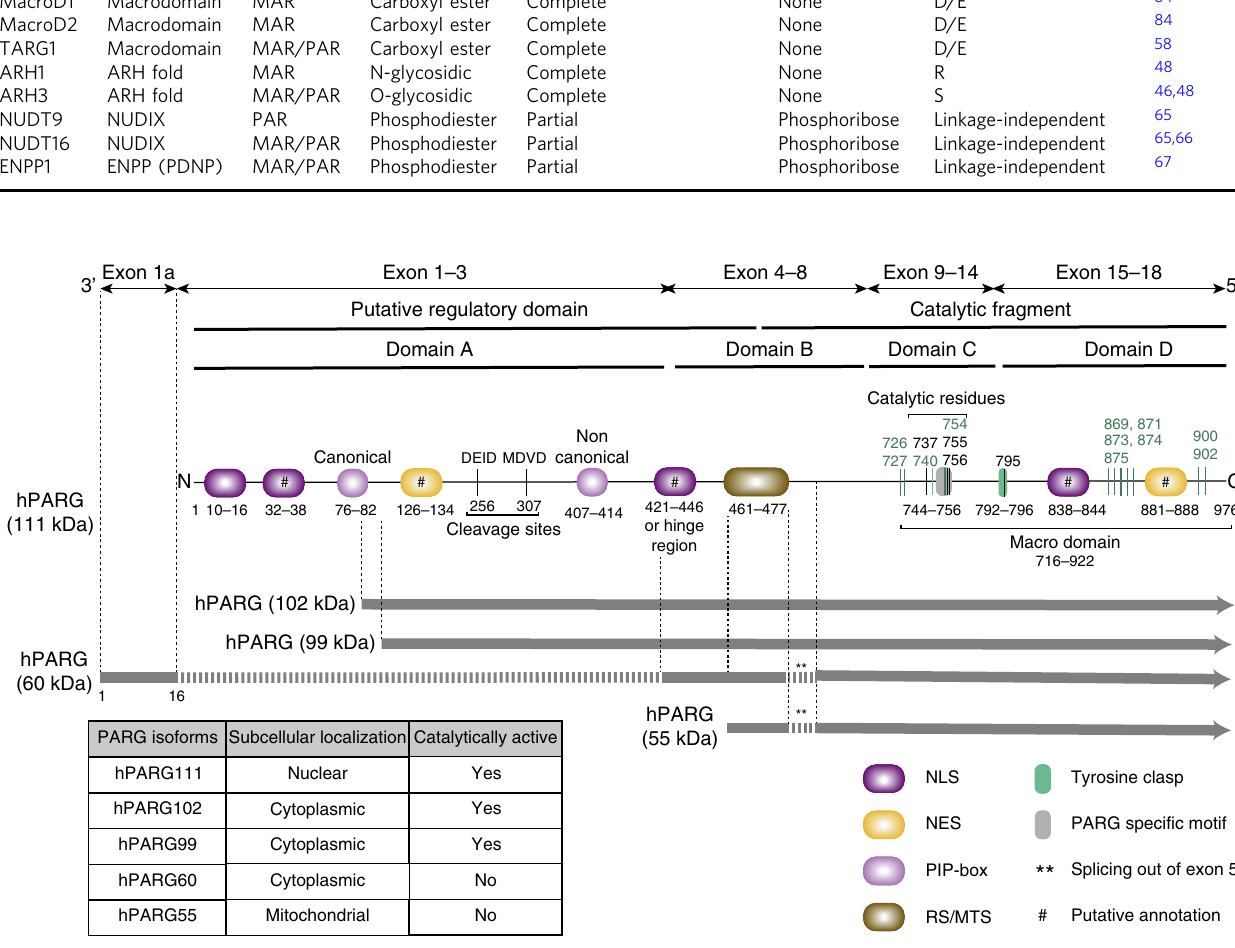
Fig. 2 Schematic representation of human PARG and its isoforms. Human PARG originates from a 3198 bp mRNA sequence with a single 2931 bp open reading frame (ORF). The ORF contains 18 exons and encodes a protein of 976 amino acids with a molecular weight of 111.1 kDa. This mRNA undergoes alternative splicing to produce different PARG isoforms. Five human PARG transcripts have been identi fi ed. Full-length human PARG (hPARG111) contains an N-terminal regulatory domain and a C-terminal catalytic domain that is essentially a macrodomain fold. hPARG102 and hPARG99 are translated from the start codons located in exon 2 and exon 3, respectively. hPARG60 results from alternative splicing that connects exon 1a, exon 4, and exons 6 – 18. Because of the usage of a facultative exon (exon 1a), hPARG60 has an alternative N-terminal protein sequence of 16 amino acids that is unique to this isoform. hPARG55 is produced from the initiation of translation at the start codon located in exon 4. Exon 5 is spliced out in both hPARG60 and hPARG55 isoforms. PARG can be sub-classi fi ed into four different domains. Domain A, which includes exons 1 – 3, forms the majority of the putative regulatory domain. This region contains two caspase-3 cleavage sites at amino acid position 256 (DEID) and 307 (MDVD). An uncharacterized nuclear localization signal (NLS) overlaps with a hinge region between the putative regulatory domain and the catalytic fragment. Furthermore, PARG comprises domain B (exons 4 – 8), domain C (exons 9 – 15) and domain D (exons 15 – 18). The latter two domains form the base of the macrodomain fold and contain the catalytic pocket and ligand binding sites. The catalytic residues (Asp737, Glu755, and Glu756) and Tyr795, which interacts with PARG inhibitor ADP-HPD are indicated as black lines. Residues colored in green have been implicated in the binding of ADP-ribose. Furthermore, colored boxes denote PARG-speci fi c motif (GGG-X 6 – 8 -QEE), regulatory segment/mitochondrial targeting sequence (RS/MTS), Tyrosine Clasp structural motif, PCNA-interacting protein